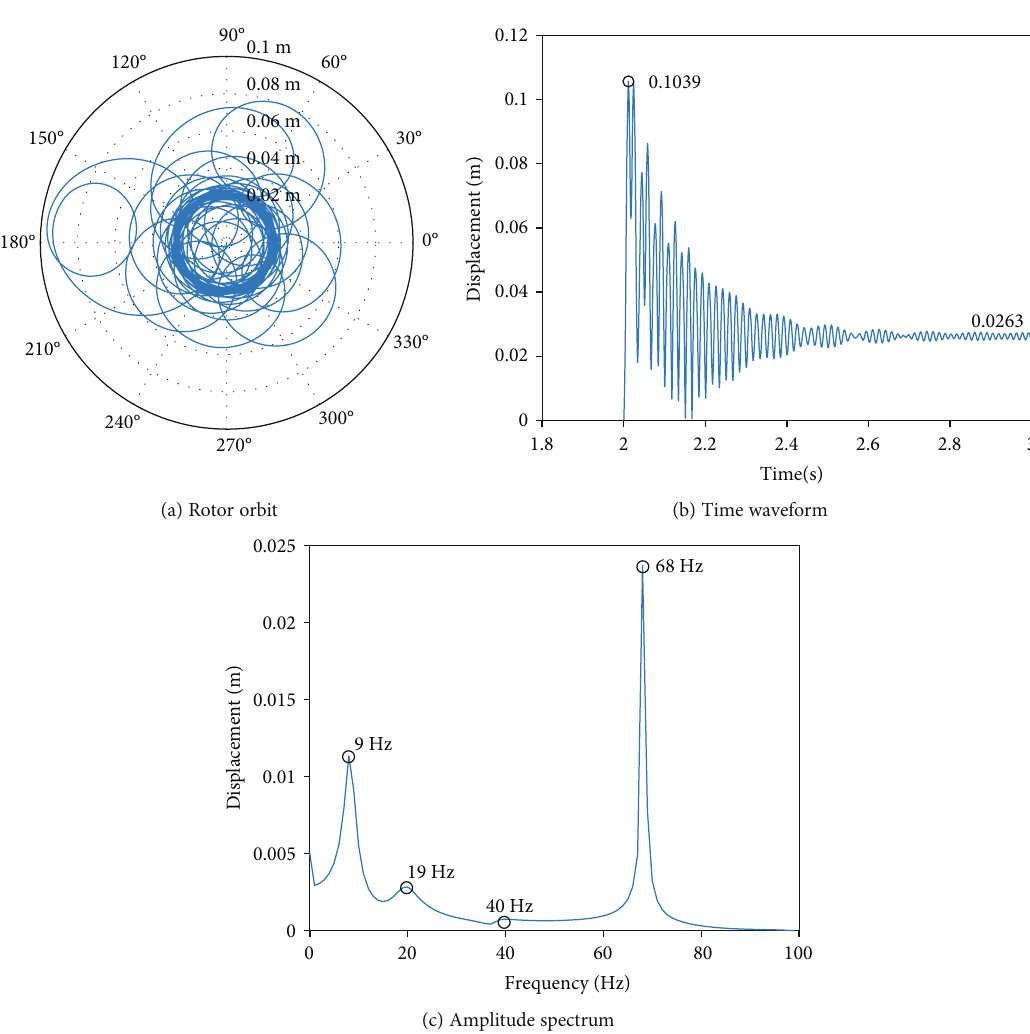
Figure 15: Response of the system with fractured fusing structure.